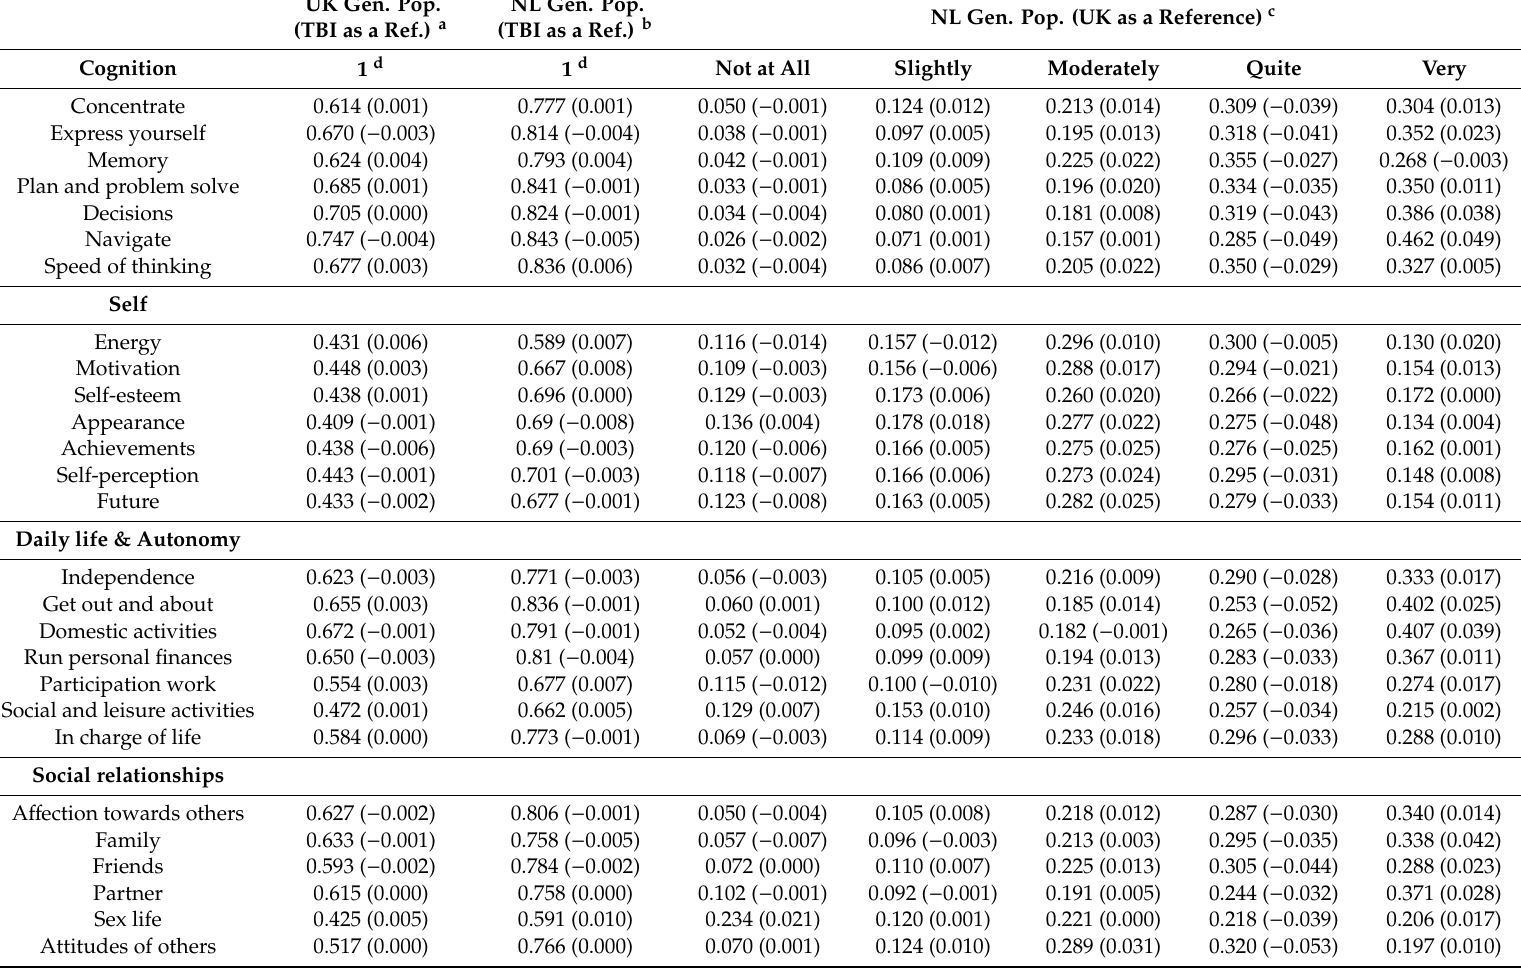
Table A5. Response probabilities (RP) of the UK and NL general population samples to choose a response category estimated in the partial invariance model and their di ff erences to the response probabilities estimated within the full invariance